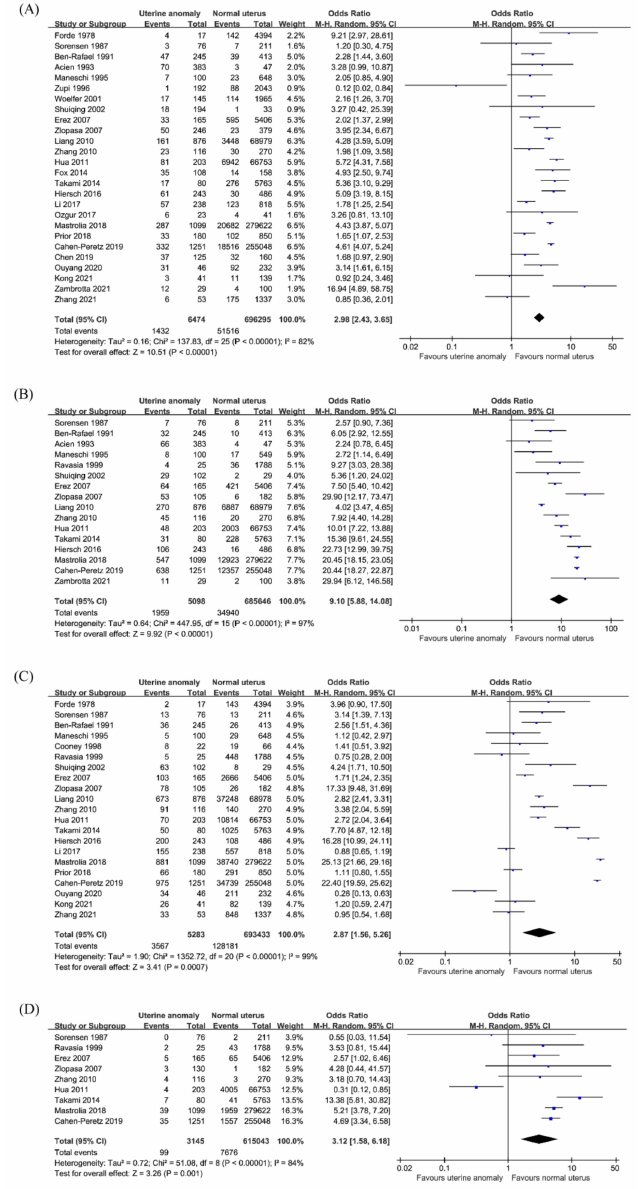
Figure 3. Obstetric outcomes in women with congenital uterine anomalies. ( A ) Preterm birth, ( B ) malpresentation, ( C ) cesarean section, ( D ) placental